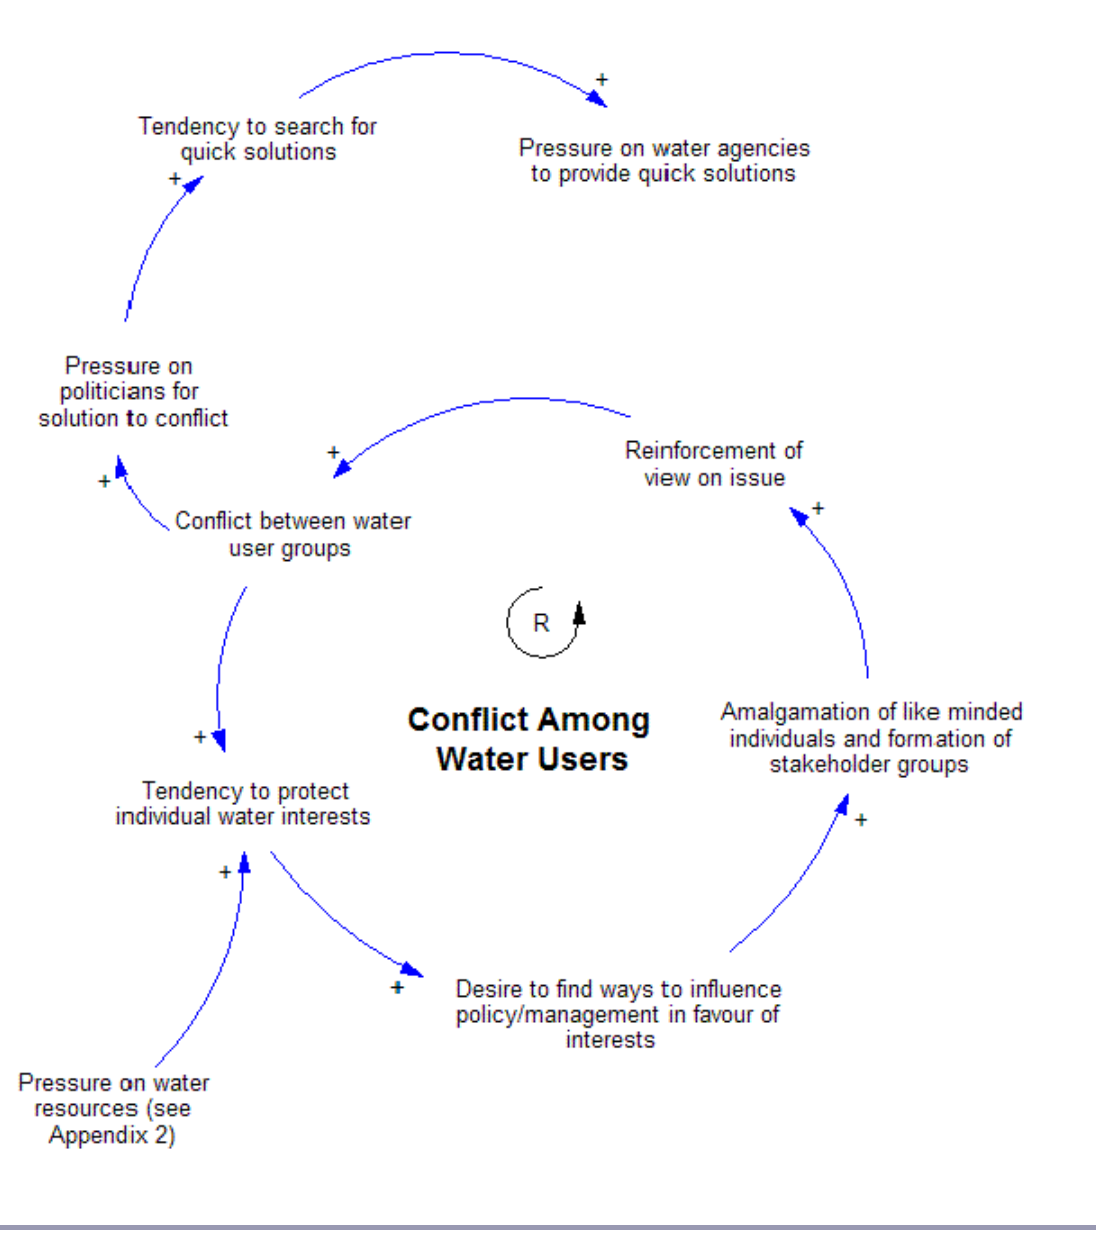
Fig. 4. Conflict among water users. The reinforcing causal loop (R) illustrates some of the social factors that result from increased pressure on water resources. As conflict over water increases, the pressure on politicians to find solutions increases. This increases the tendency for politicians to search for quick solutions, resulting in increased pressure on water agencies to provide the